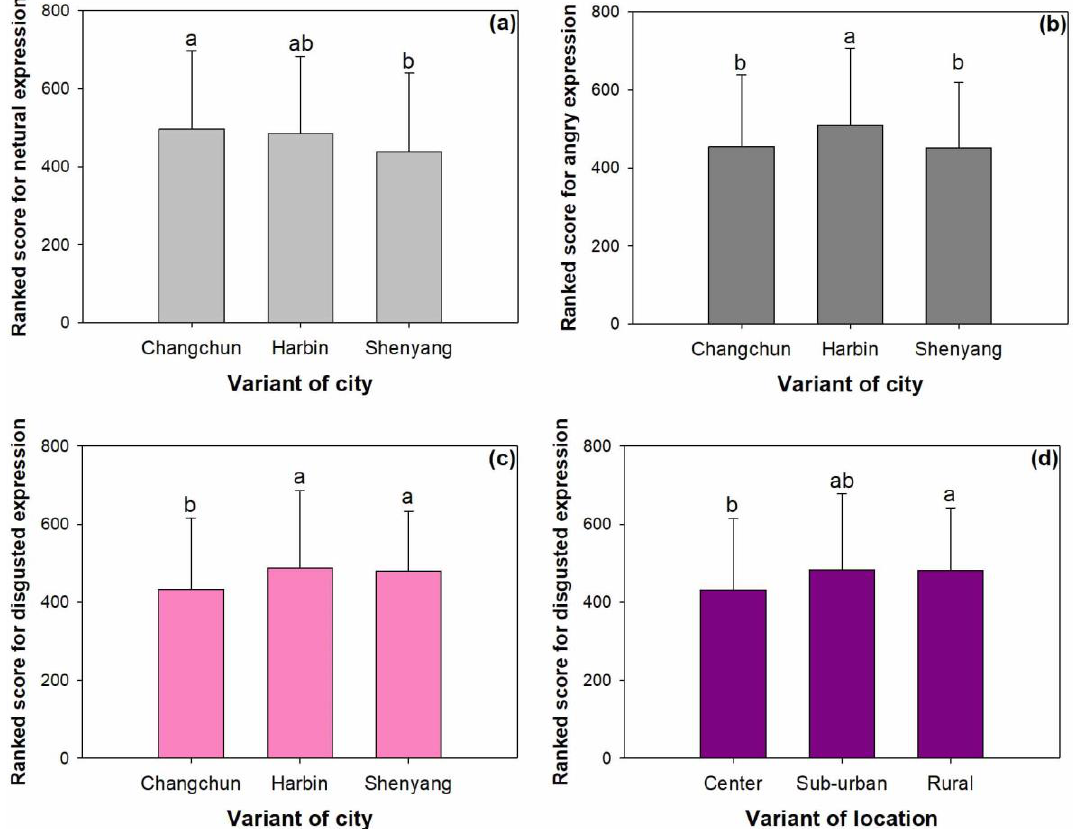
method from 0.05).